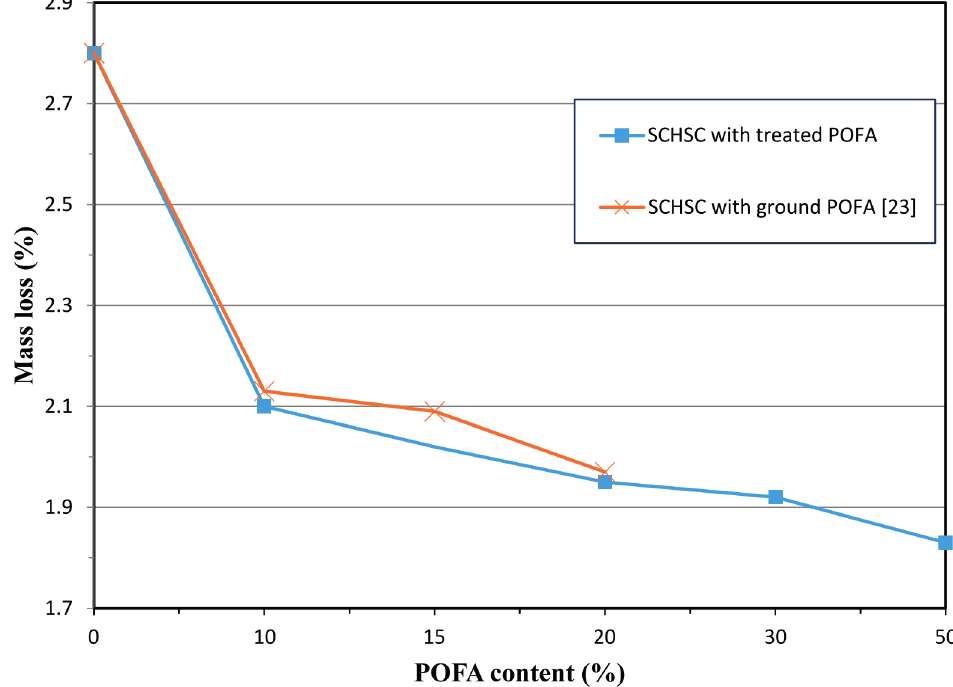
Figure 13. Relationship between mass loss and treated POFA